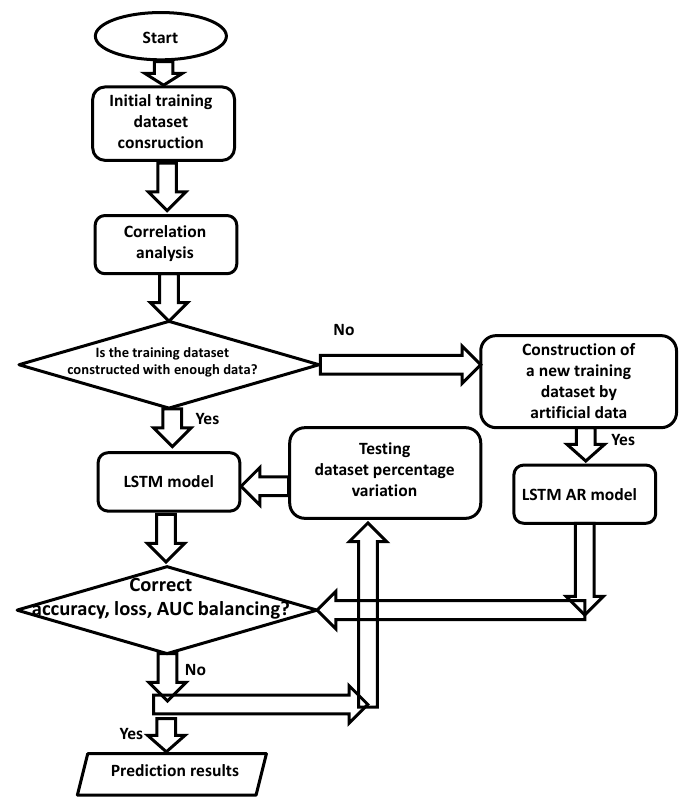
Figure 15. Flowchart representing automatisms for LSTM / LSTM-AR- DSS model predicting diabetes.